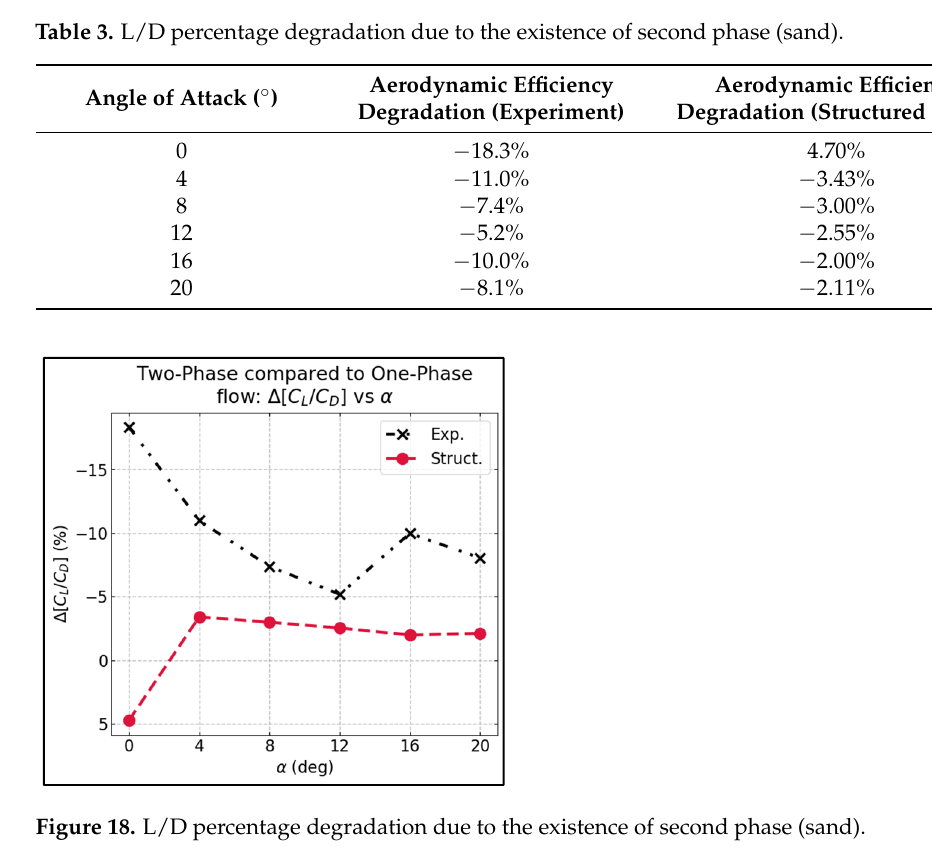
Figure 17. Static pressure distribution around airfoil at 75% of wingspan, angle of attack 20 degrees,